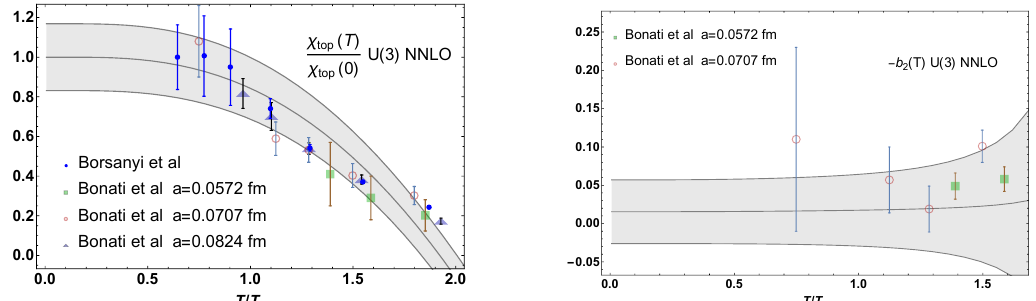
Figure 4 . Left: temperature dependence of the topological susceptibility calculated within the U(3) formalism compared to lattice data from [12] and [14]. Here, we have taken T c = 155 MeV. Right: temperature dependence of the b 2 coe(cid:14)cient, with lattice data from